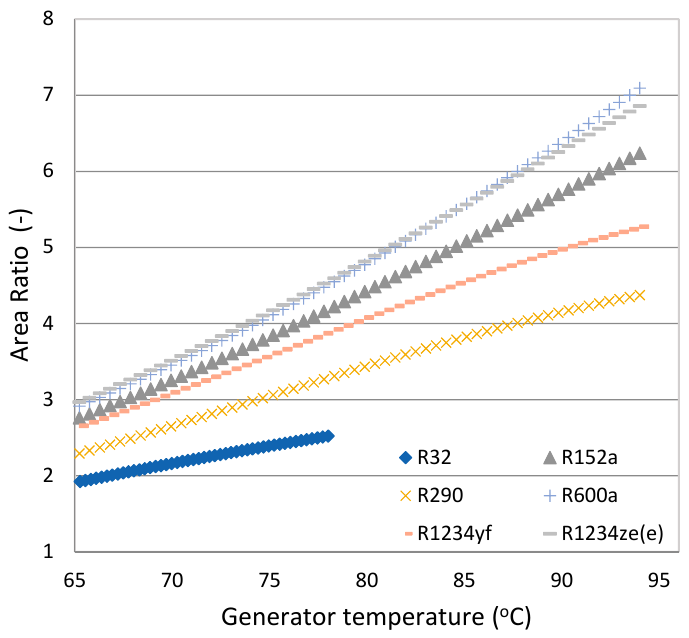
Figure 9. The area ratio as the function of generator temperature.